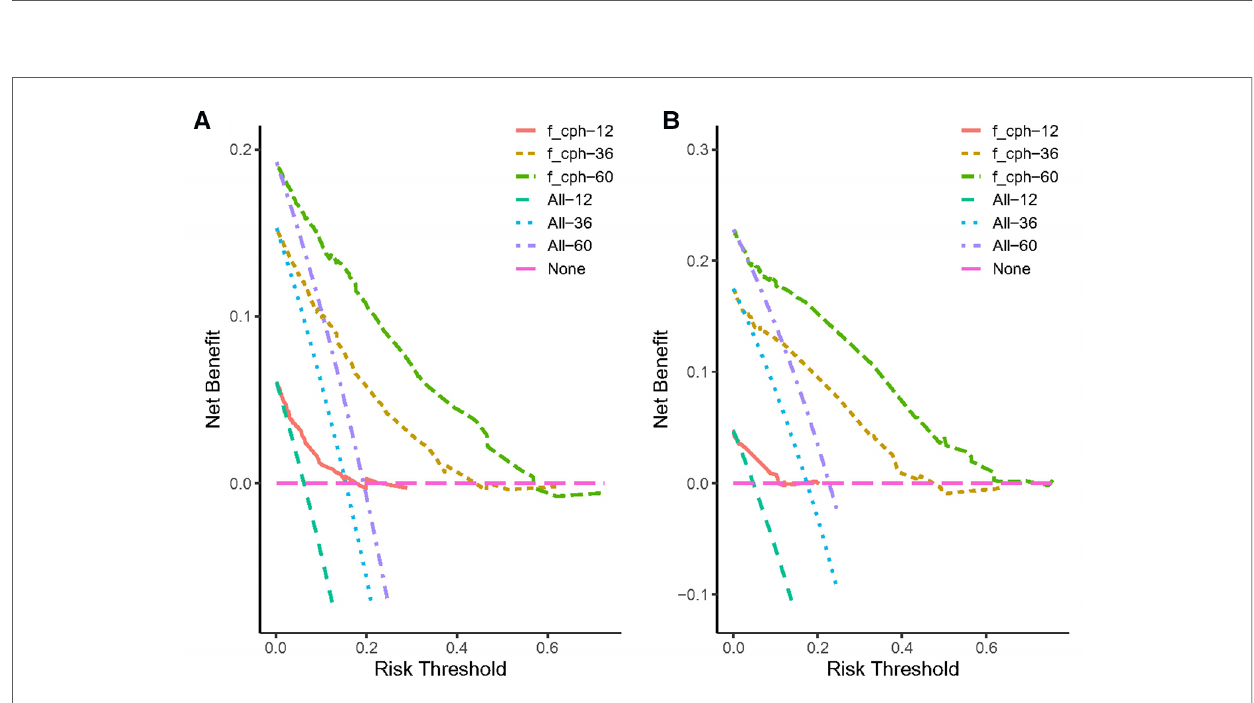
FIGURE 7 The decision curve analysis of the nomogram for predicting 1-, 3-, 5-year cancer-speci fi c survival in the training cohort ( A ) and the validation cohort ( B